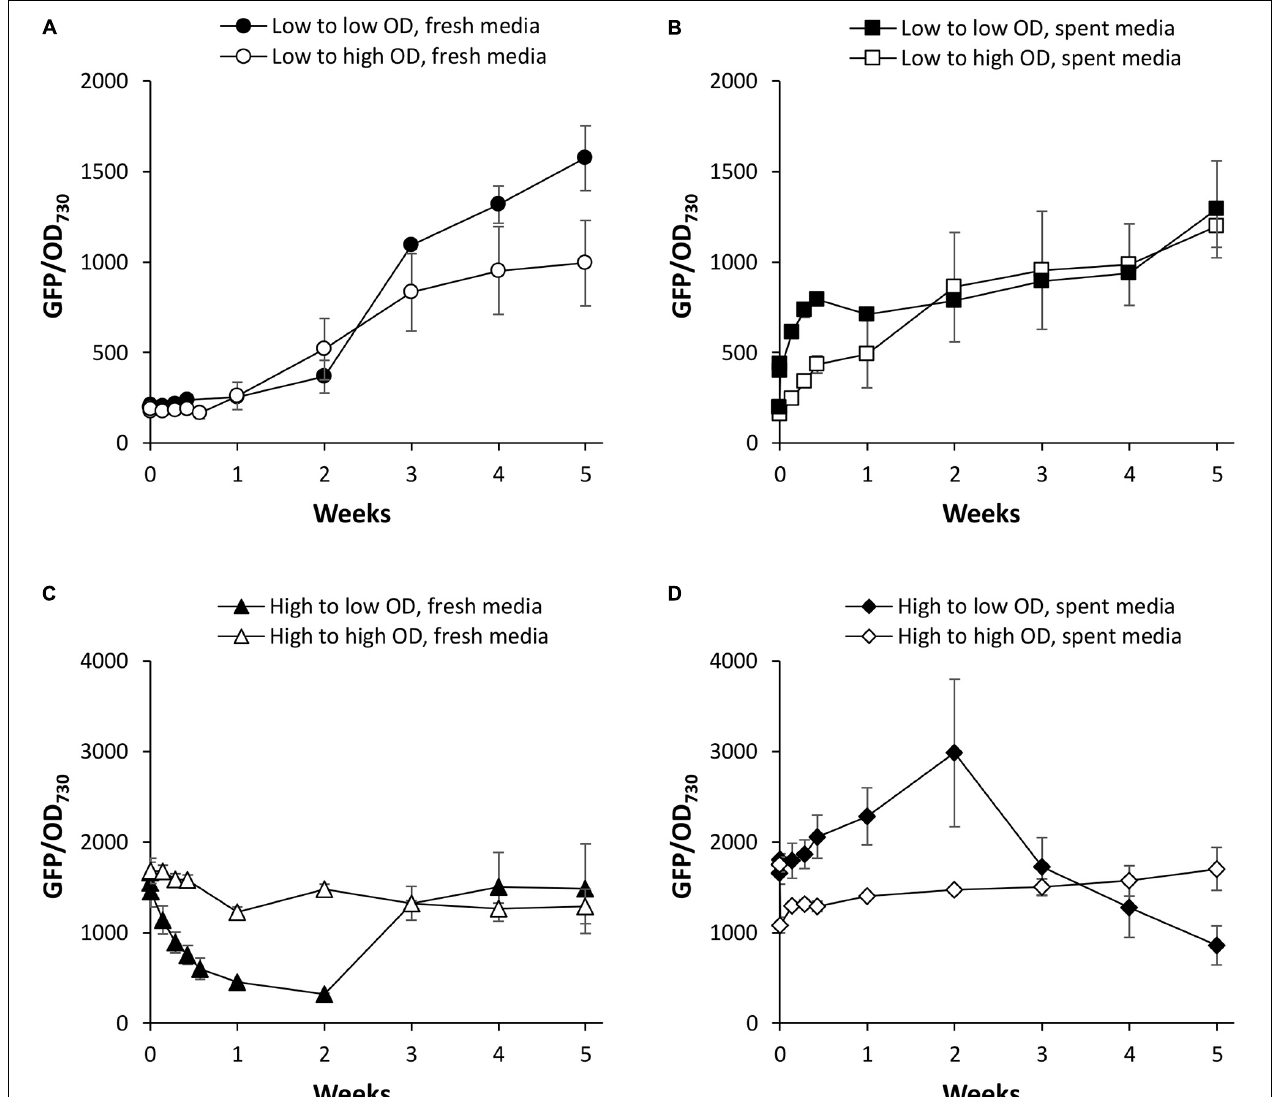
FIGURE 5 | The effect of culture density on PndbA600 activity. PndbA600 activity (GFP fluorescence normalised to OD 730 ) in Synechococcus PndbA600:GFP cultures pre-grown to certain density and resuspended to another density at time point 0. Cultures shown in (A,B) were started from young, low density cultures with low promoter activity (OD < 5, GFP < 300). Cultures shown in (C,D) were started from mature, high density cultures with high promoter activity (OD > 12, GFP > 850). Cultures were resuspended to low (black symbols) or high (white symbols) density in fresh control media (A,C) or spent media of stationary phase cultures (B,D) . Data are means ± S.E.M. of three independent cultures. Accompanying growth curves are presented in Supplementary Figure S5